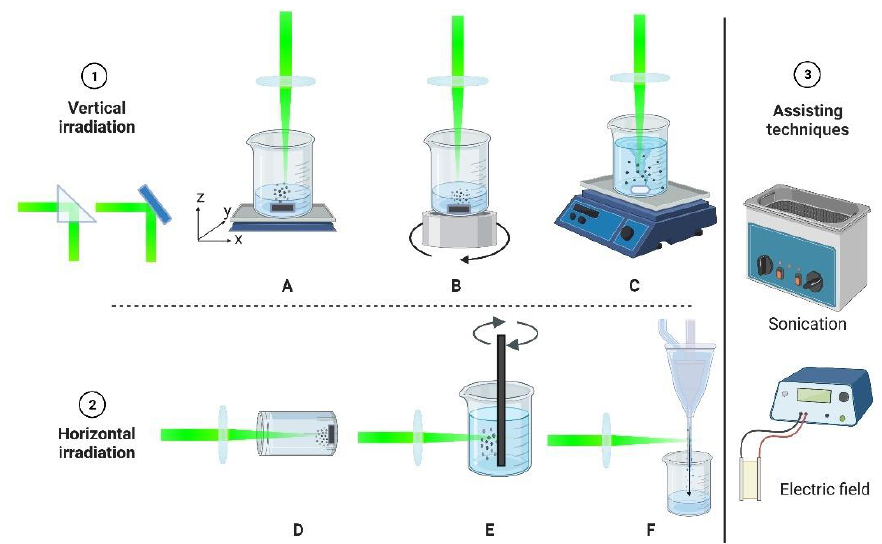
Figure 3. Different configurations for a PLAL setup, ( A ) XYZ translation stage, ( B ) rotational stage, ( C ) magnetic stirring, ( D ) fixed horizontally, ( E ) rotational rod, and ( F ) liquid jet flow. (Created with BioRender.com)